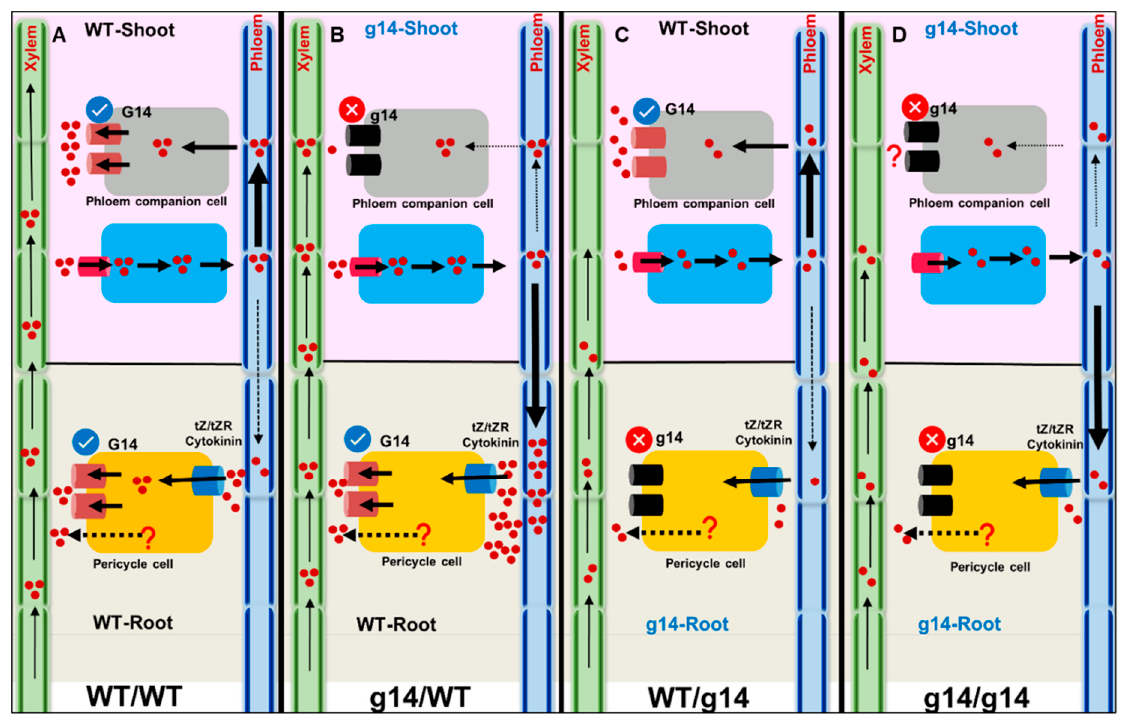
Figure 1. Schematic representation of the role of AtABCG14 (G14) in cytokinin transport and corresponding leaf distribution and shoot phenotype. AtABCG14, along with an unknown protein, loads tZR/tZ into the root xylem. ( A ) In WT homografts, phloem transports most cytokinins to the minor veins, and AtABCG14 in PCCs mediates cytokinin release to the apoplast. A small amount of phloem cytokinin retrogrades to the root. The functional AtABCG14 in root and shoot distribute cytokinins from veins to the lamina, resulting in GUS expression and better shoot phenotype. ( B ) In the heterograft atabcg14 /WT, functional AtABCG14 in roots transports most of the cytokinin to shoots; however, phloem unloading is suppressed in AtABCG14-deficient shoots, and the majority of root-synthesized cytokinin is retrograded to the roots. The suppressed phloem unloading results in a defective shoot phenotype and no GUS signals in the leaf. ( C ) In the heterograft WT/ atabcg14 , an unknown protein loads cytokinin into the xylem. Functional shoot AtABCG14 translocates cytokinin into the apoplast, improving the shoot phenotype and GUS expression compared to atabcg14/ WT. ( D ) In homograft atabcg14/atabcg14 , a disrupted root-and-shoot AtABCG14 results in completely suppressed shoot phenotype and absence of GUS staining. There could be a different unknown mechanism for the transport of cytokinin and further unloading at phloem. tZ—trans-zeatin; tZR—tZ-riboside; G14—AtABCG14; PCC—phloem companion cells; PC—pericycle cells, ?-unknown mechanism. The grey and blue rectangle box denotes the phloem companion cell. The figure is modified from Zhao et al., 2021.